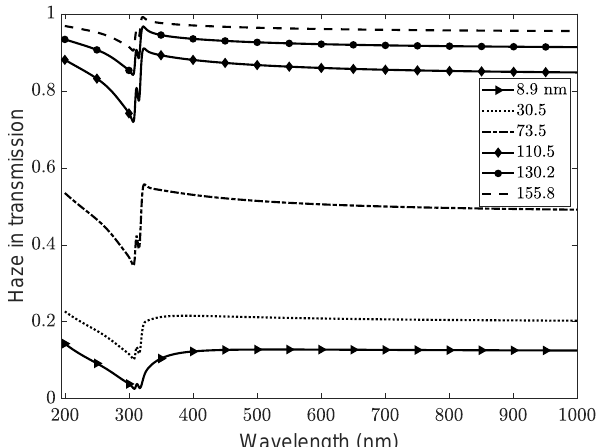
Figure 3. The (normalized) contribution of diffuse scattering is given by the haze, here in transmission H T = ( T tot − T spec ) / T tot , for different morphologies and rms roughnesses of the ZnO/Ag interface of sample type 2. The silver plasmon peak is observed around 315